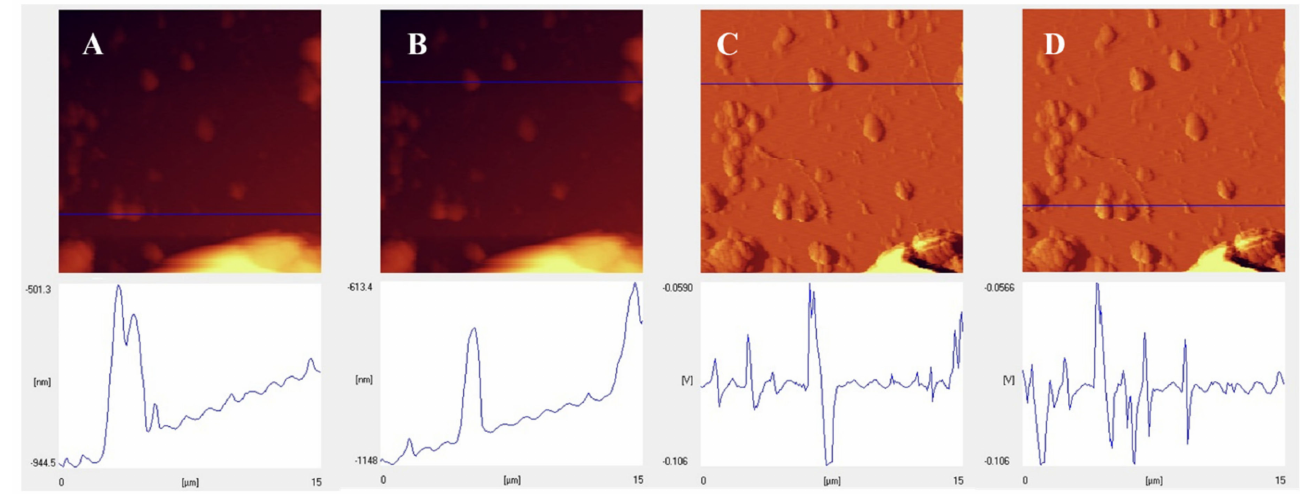
Figure 3. Line analysis roughness with different positions ( A – D ) images of the NH 2 -MIL-53@H 2